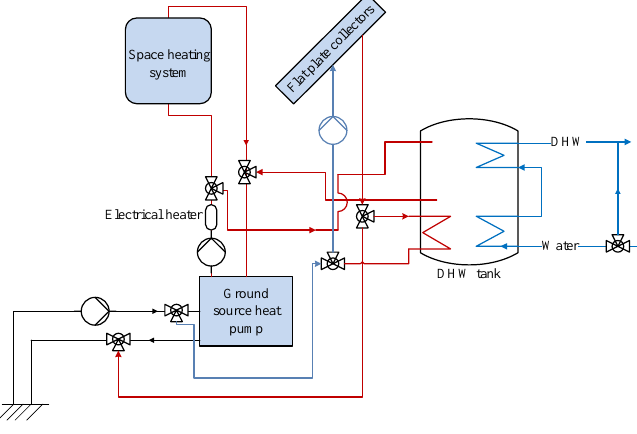
Figure 2. Systems schematics for the building with the GSHP and solar thermal system.